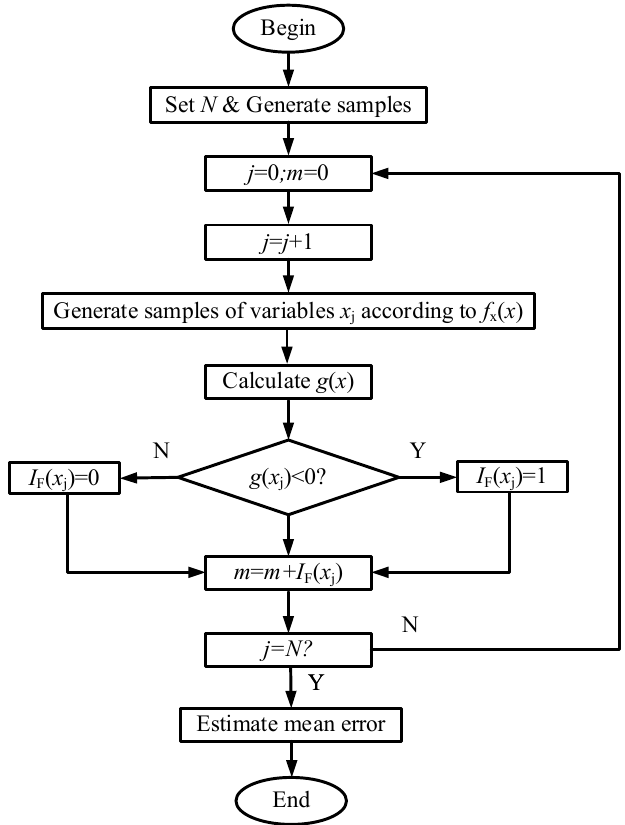
Figure 6 . Flow chart of Monte Carlo reliability analysis. Figure 6. Flow chart of Monte Carlo reliability